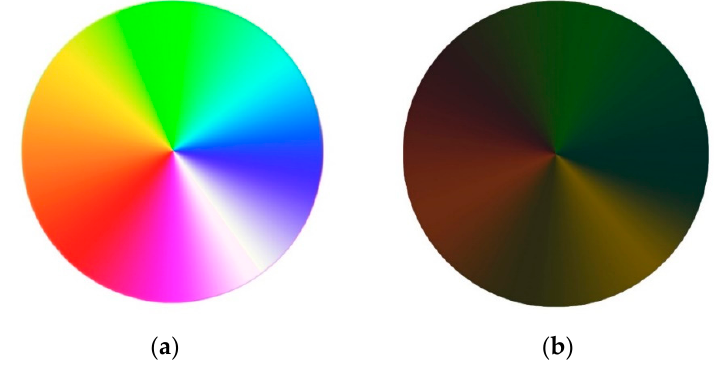
Figure 2. The color wheels used in the self-reported questionnaire (SRQ). ( a ) The wheel of the light colors, and ( b ) the wheel of the dark colors. Source: researcher’s own design.